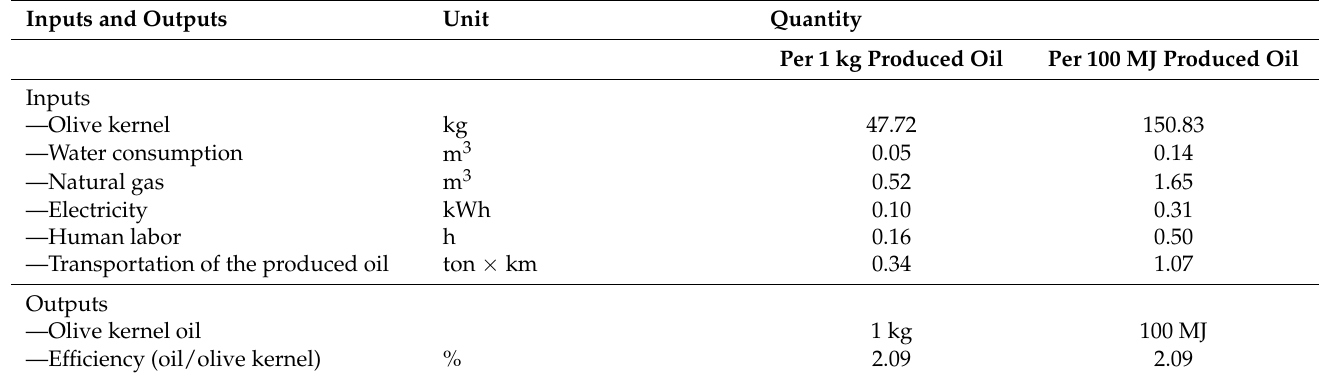
Table 1. Main primary inventory data for the olive kernel oil production